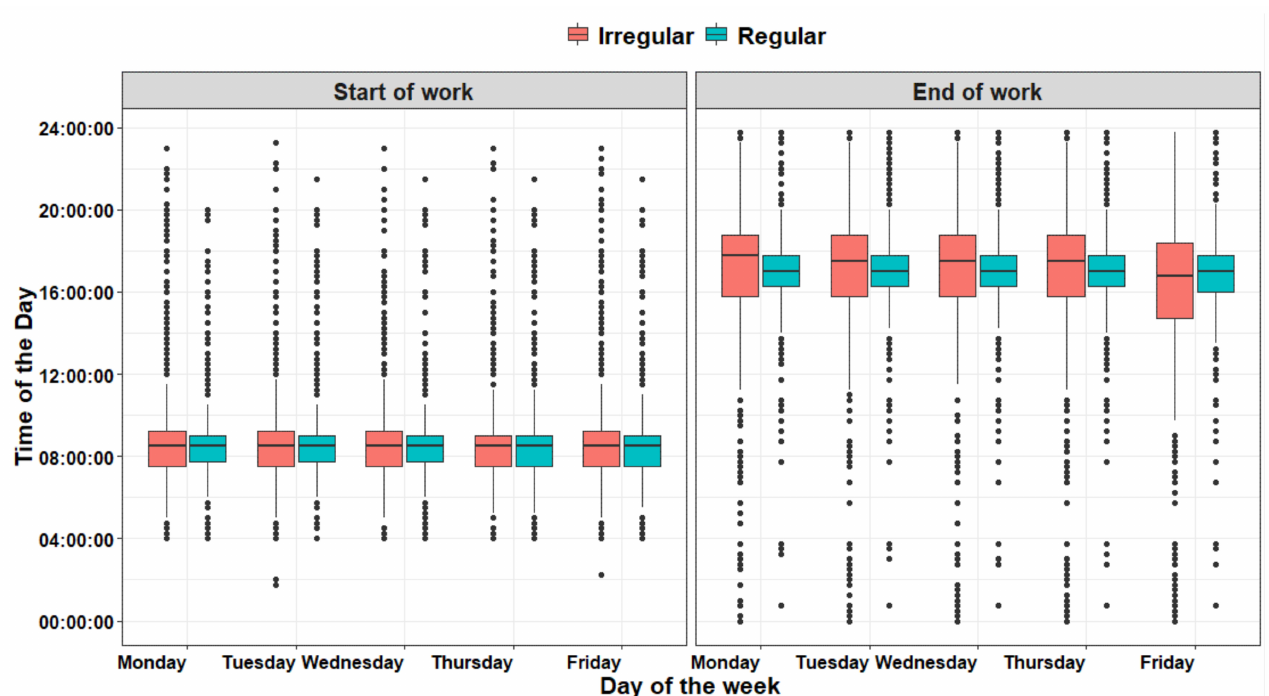
Figure 3. Distribution of work dairies relative to the start and end of work